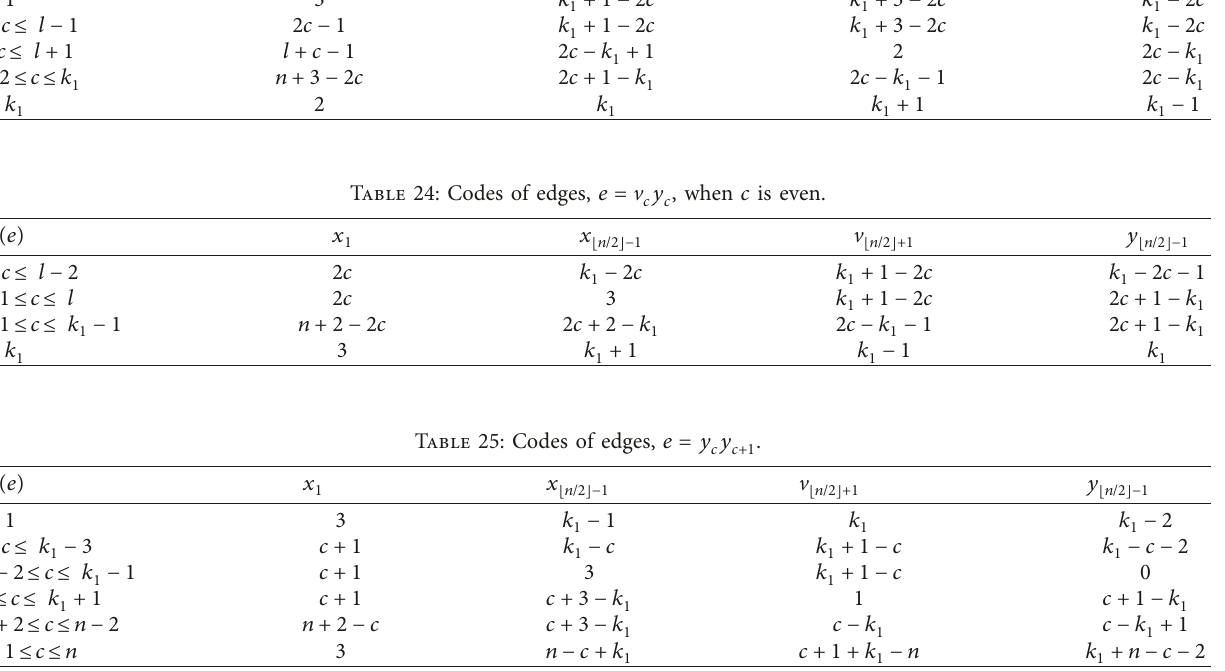
Table 23: Codes of edges, e � v